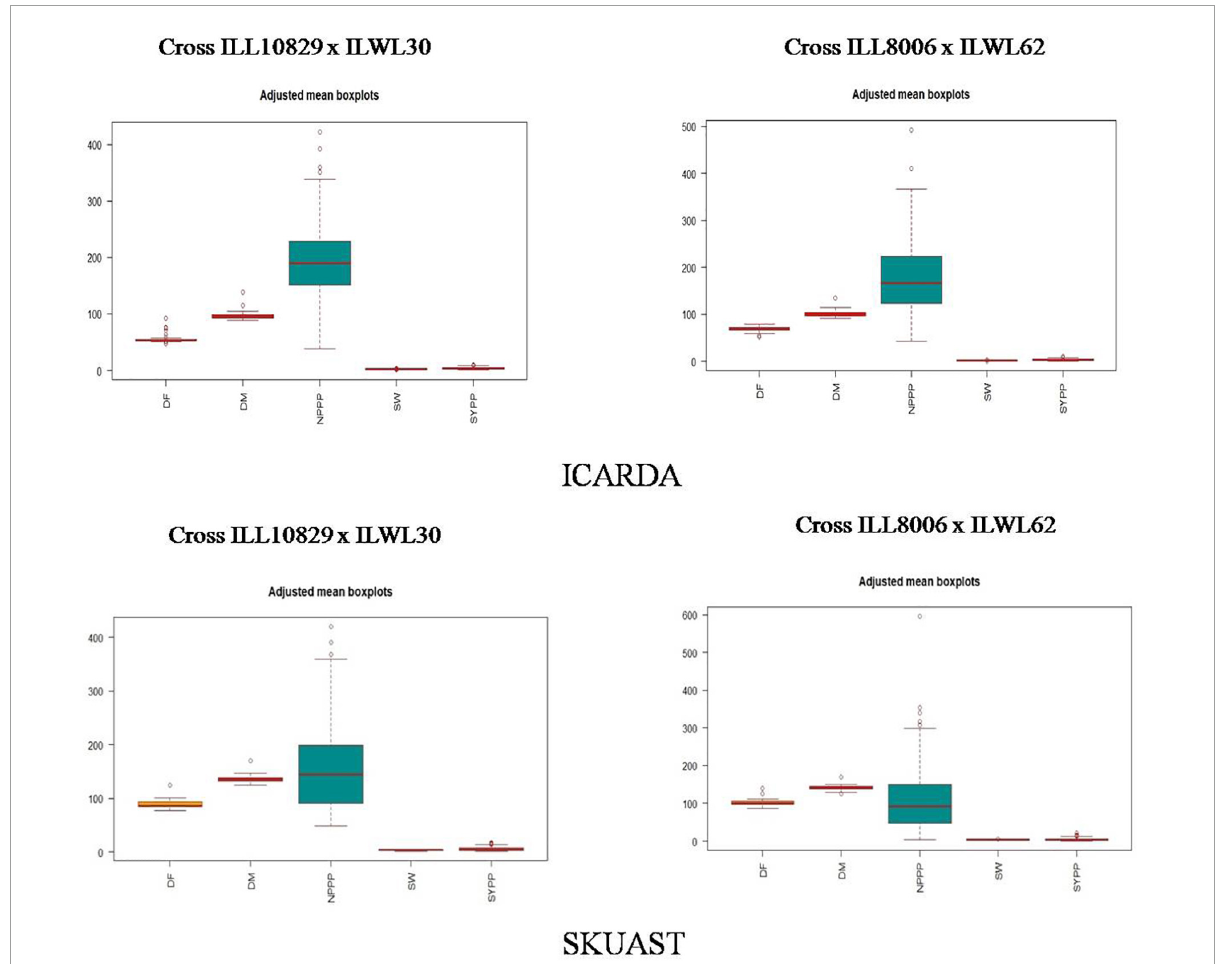
FIGURE3 Estimation of adjusted mean boxplots for different traits in lentil interspecific derivatives at ICARDA and SKUAST, India. DF, days to 50% flowering; DM, days to 80% maturity; NPPP, number of pods plant - 1 ; SW, 100-seed weight; SYPP, seed yield plant - 1 .